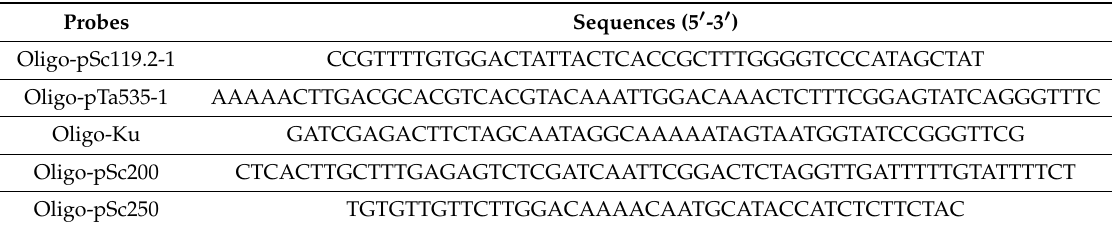
Table 2. The nucleotide sequences of oligonucleotide